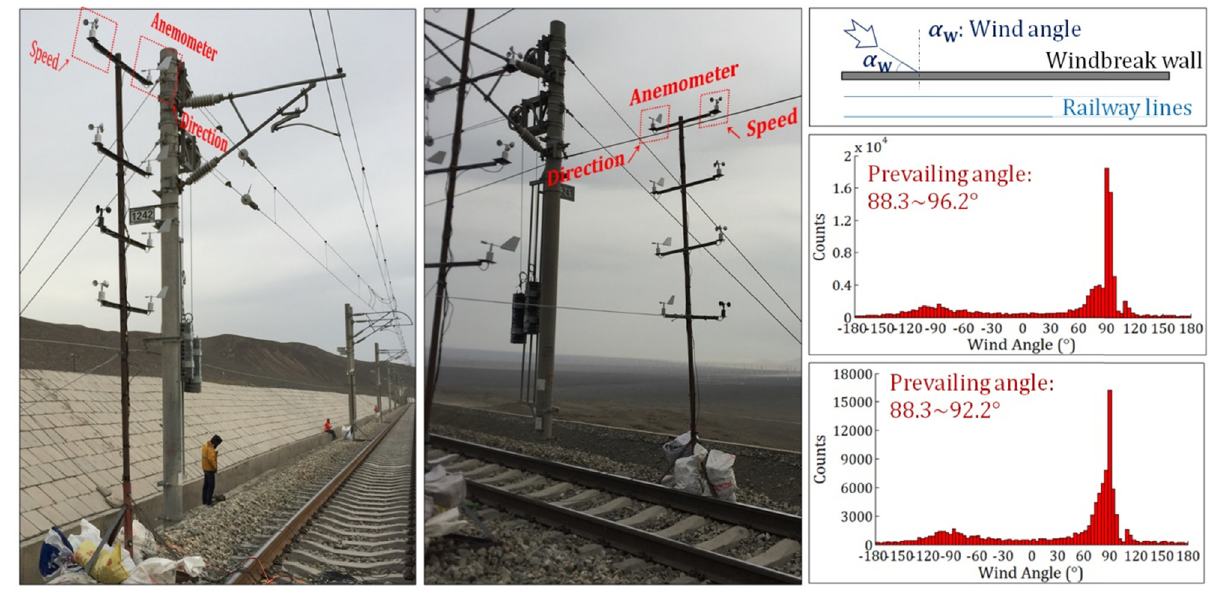
Figure 4: Wind measurement on railway line in